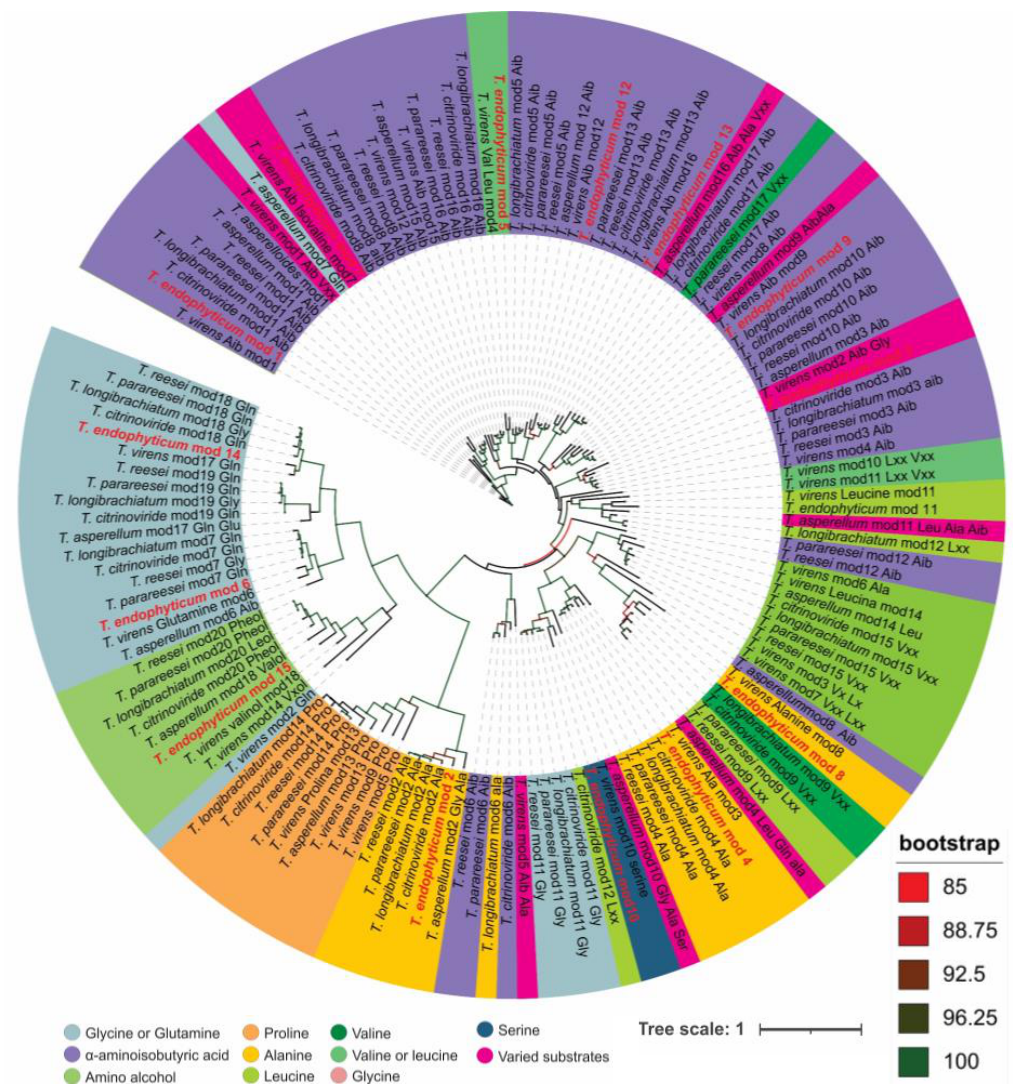
Figure 4. Phylogeny of 15-res NRPS adenylation modules.